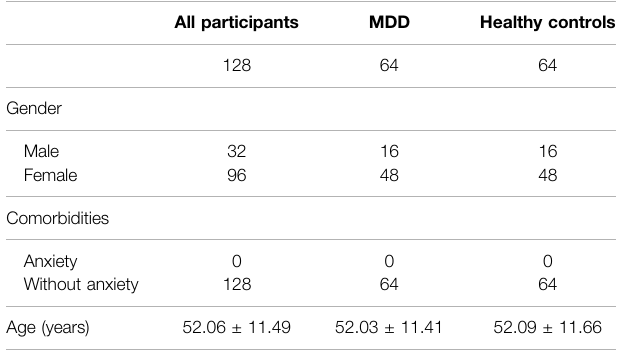
TABLE 1 | Clinical and demographic characteristics of participants (GSE98793) included in the present study. All